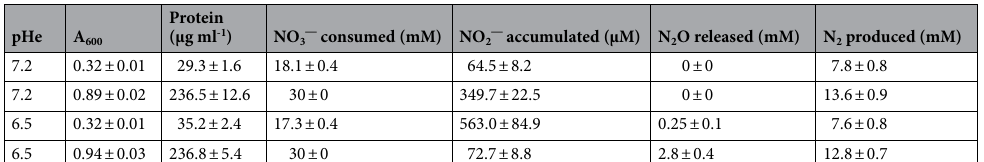
Table 1. Effect of pH on nitrogenous compounds and gases detected during denitrification. Cells were grown in anaerobiosis with nitrate (30 mM) in minimal medium at different initial pH (6.5 or 7.2). Samples were taken at early (A 600 ⁓ 0.3) or late (A 600 ⁓ 0.9) exponential growth phase. Data are means ± SD of three independent biological replicates (n = 3). N-oxyanions and denitrification gasses were determined as indicated in experimental procedures. pHe: extracellular